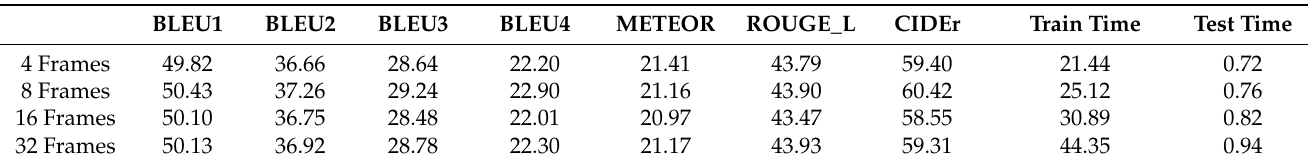
Table 3. Results of the second proposed